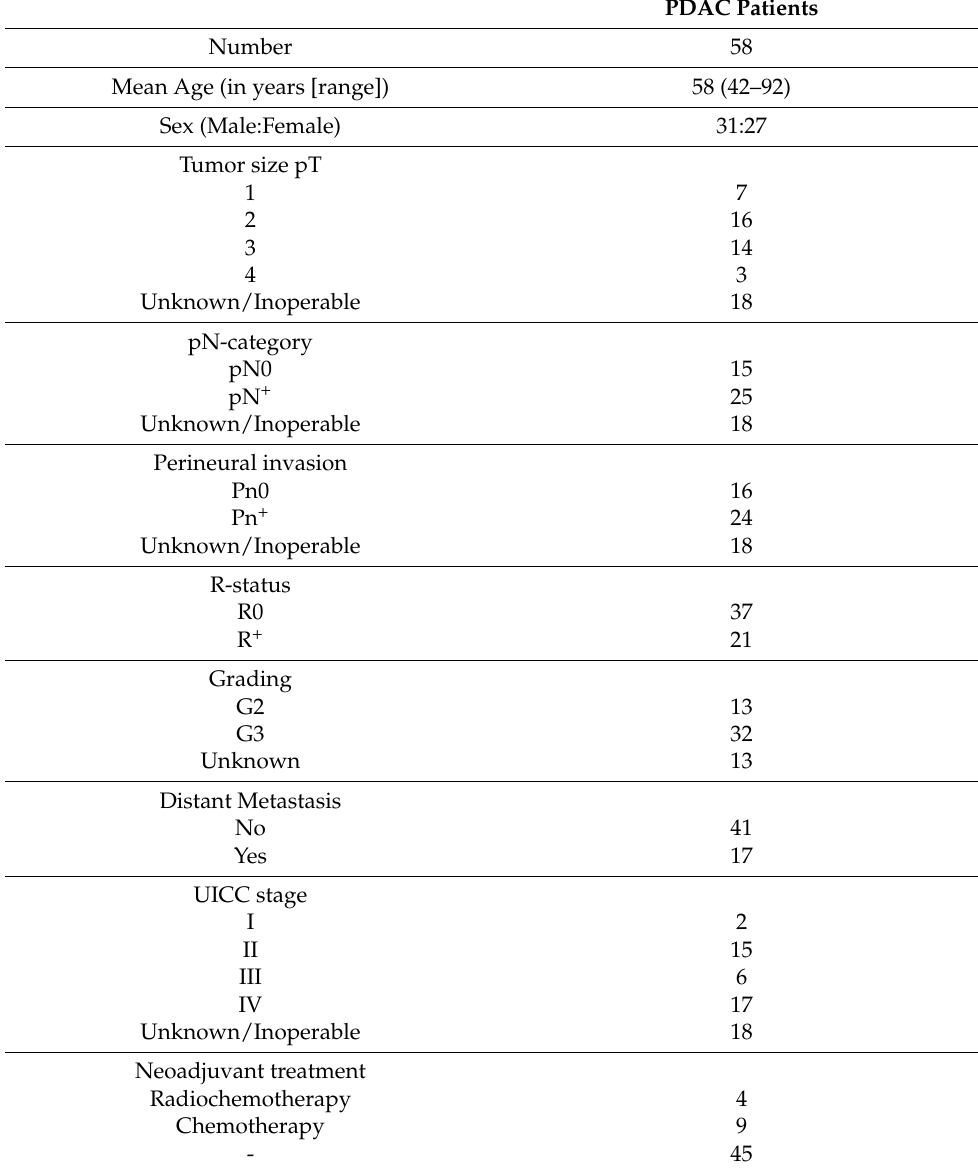
Table 1. Clinico-pathological parameters of the PDAC study